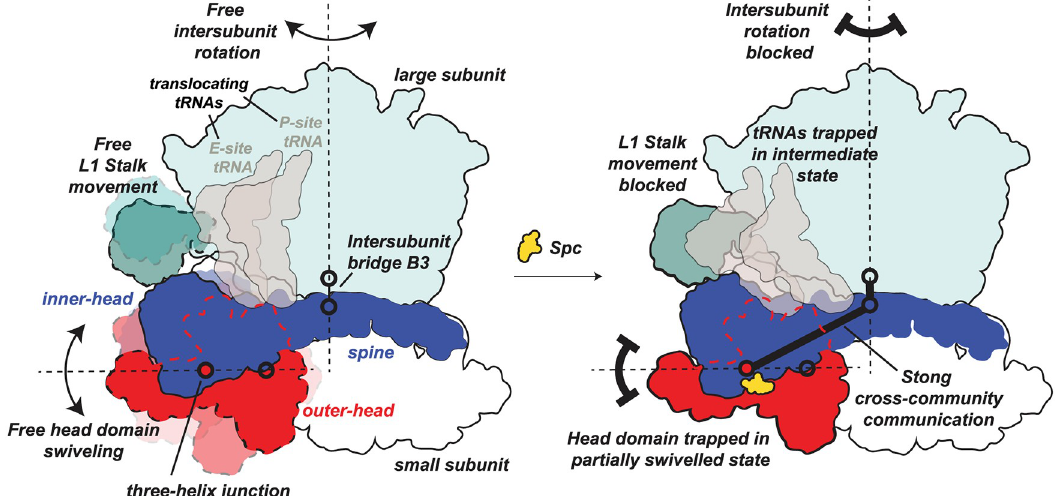
Fig 6. Effect of Spc on ribosome dynamics. Spc binding blocks free swiveling of the head domain and halts intersubunit rotation due to strengthened through-space interactions between pivot regions, thereby trapping the ribosome in a partially swiveled state. Black dashed lines indicate movements involving head swiveling and L1 stalk movement during translocation. Red dashed lines outline the portion of the outer-head domain concealed behind the inner-head domain. Spc, spectinomycin.